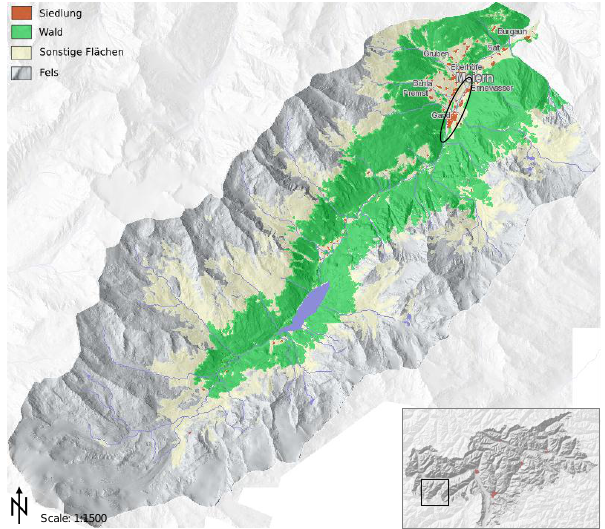
Figure 1. Overview of the location of the research valley in the Autonomous Province of Bolzano (smaller right, 2011a) and the valley of Martell (indicated in the square) and its natural features itself (University of Innsbruck, 2008) . The study areas of the villages Gand and Ennewasser are circled. Legend: red – settlement area, green – forest, light yellow – other areas such as alps, meadows and pasture areas, grey – rocks and high alpine environment.